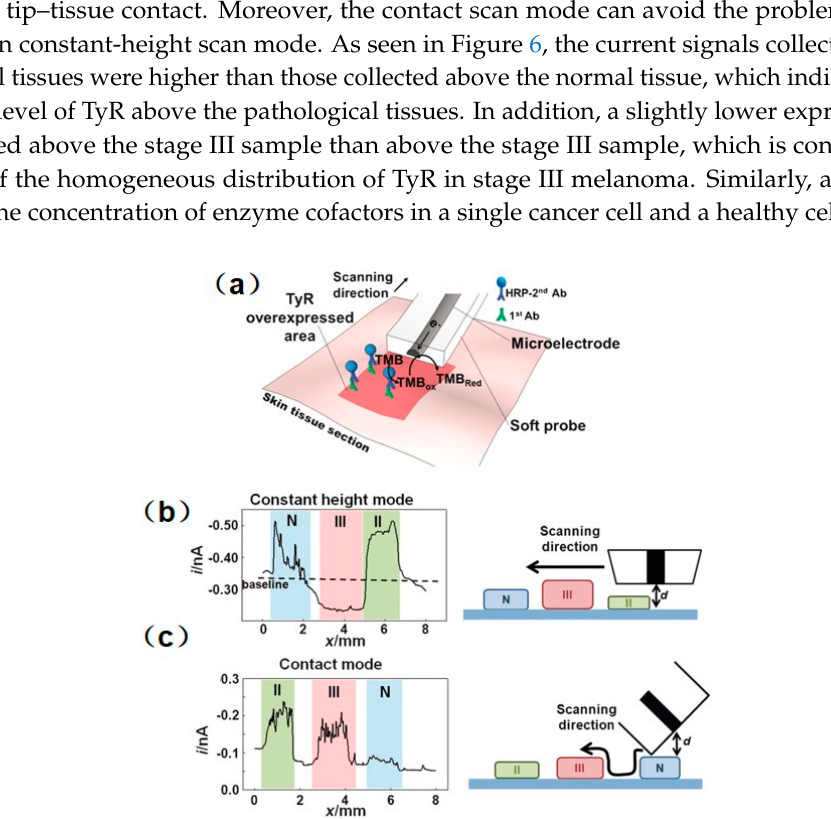
Figure 6 . ( a ) Schematic representation of the immunoassay-based detection strategy to map the TyR distribution in tissue sections by using a soft SECM probe. SECM line scans in constant-height mode using a conventional microelectrode ( b ) and in contact mode with a soft SECM probe ( c ) over a tissue microarrays containing normal skin (N), stage II melanoma (II), and stage III melanoma (III) melanoma tissue sections. Copyright (2016) John Wiley & Sons, Ltd.